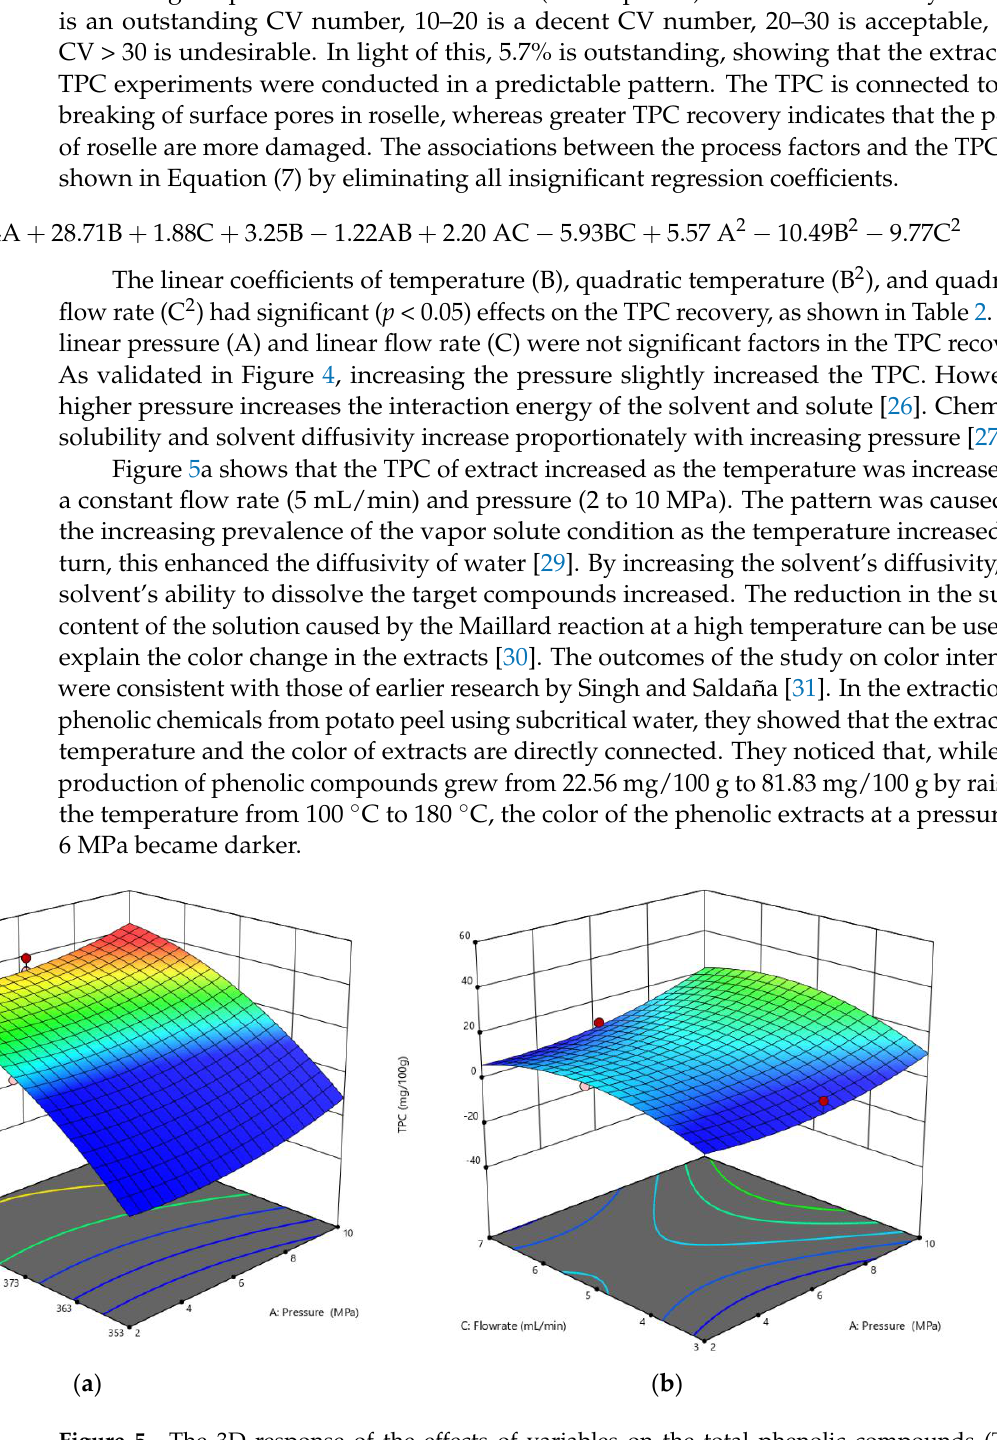
Figure 5. The 3D response of the effects of variables on the total phenolic compounds (TPC) (mg/100 g) at ( a ) a constant flow rate of 5 mL/min and ( b ) a temperature of 393 K.